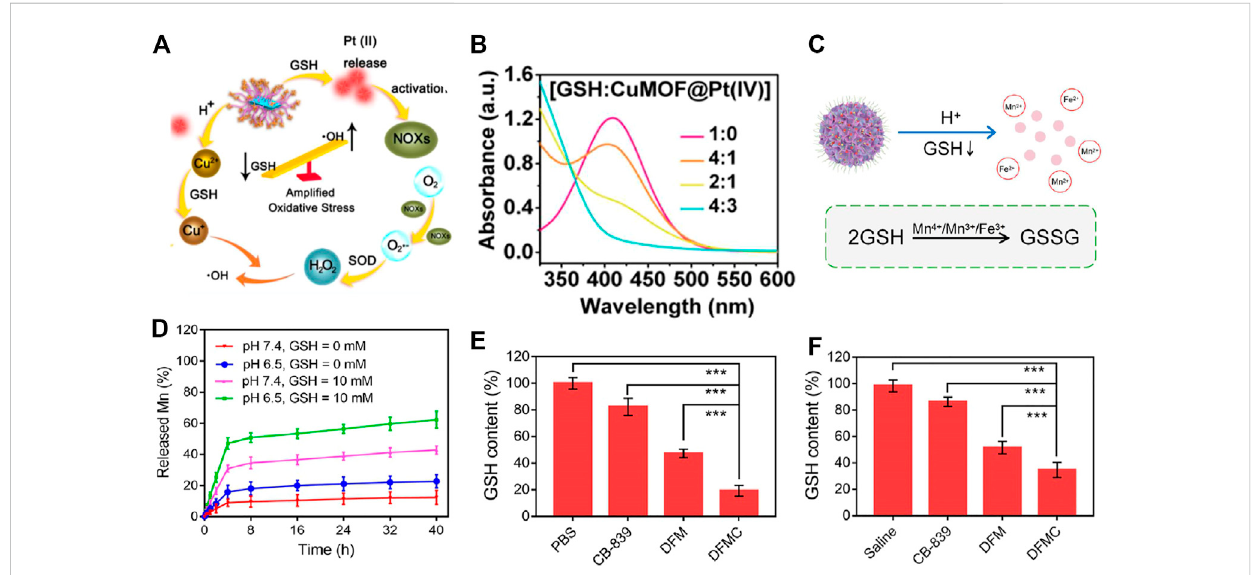
FIGURE 4 (A) Schematic illustration of GSH consuming-sensitized chemotherapy. (B) The capability of depleting GSH with CuMOF@Pt (IV) using 5, 5 ′ -dithio- bis-2-(nitrobenzoic acid) (DTNB) as an indicator. Reproduced with permission. Copyright 2021 Elsevier. (C) DFMC was decomposed in an acidic environment and GSH was oxidized to GSSG via reacting with Mn 4+ /Mn 3+ /Fe 3+ . (D) Release state of Mn ions in the presence or absence of GSH with different pHs. (E) The level of GSH in CT26 cancer cells and (F) tumor tissue in the treatment of PBS, CB-839, DFM (DFMC without CB-839)